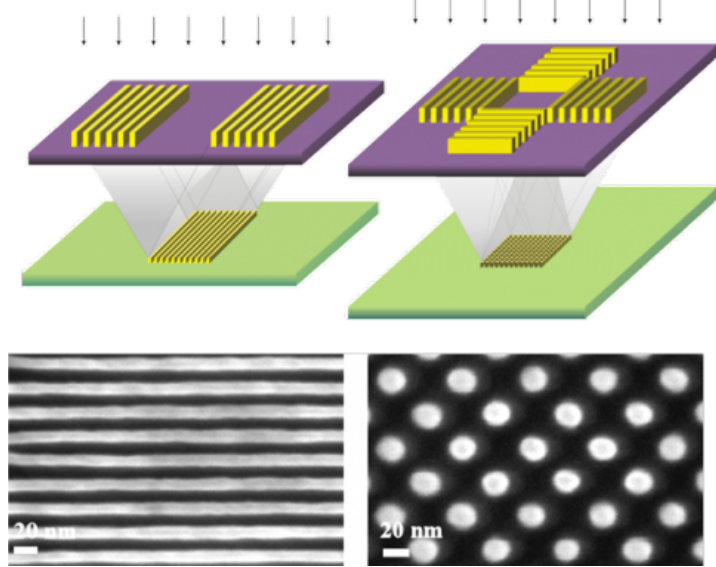
Figure 14. Schematic overview of optical projection lithography